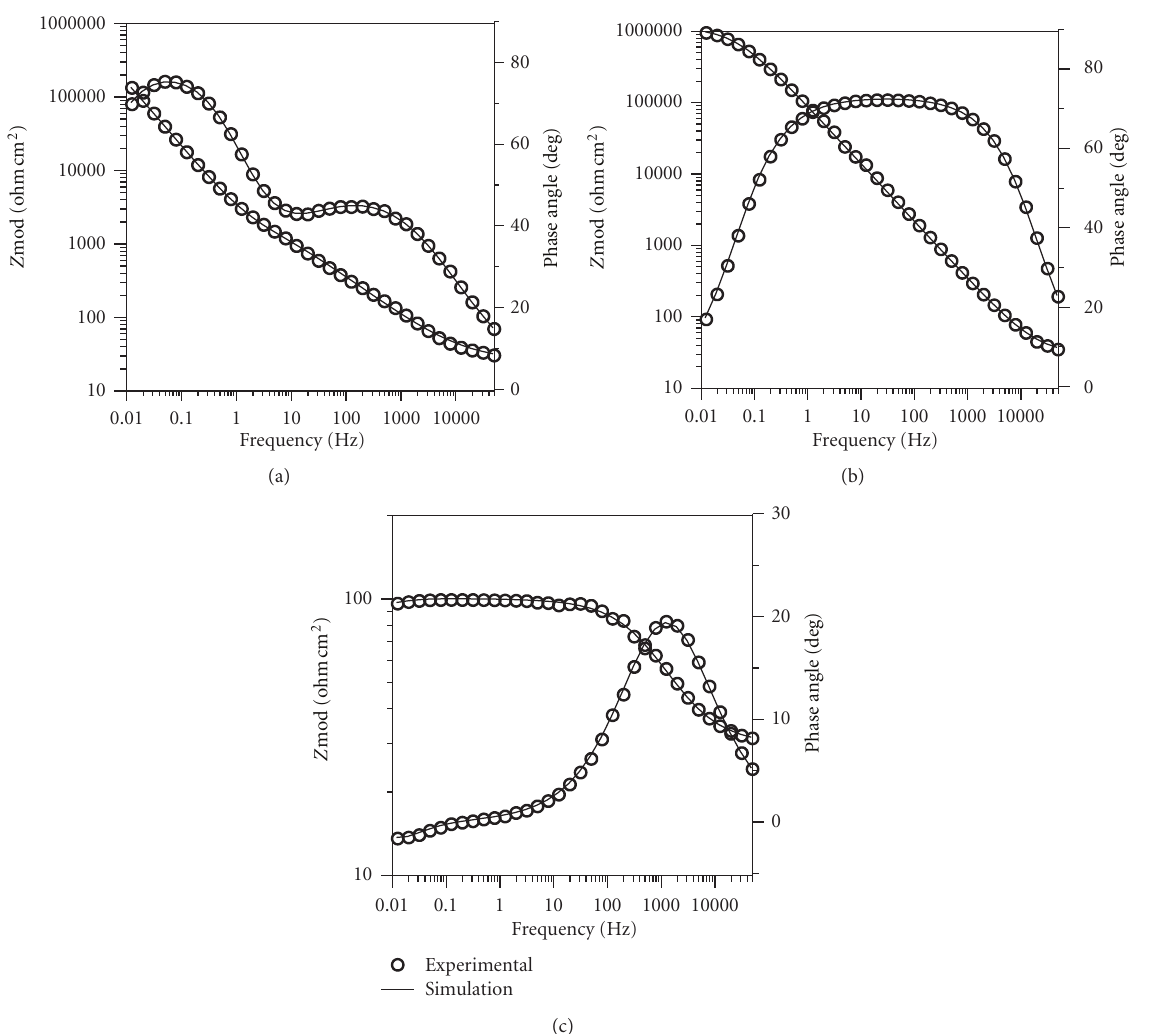
role that Nb plays as an alloying element is by increasing the resistance of NiTi alloy to pitting